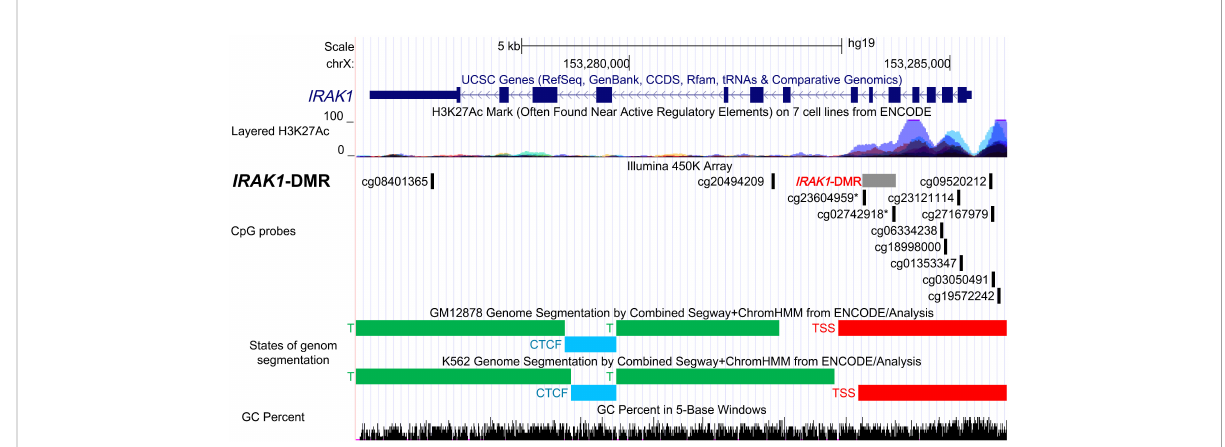
FIGURE 4 Functional characterization of the differentially methylated region in IRAK1 gene ( IRAK1 -DMR) using ENCODE Data in the UCSC Genome Browser. Genomic position of IRAK1- DMR is shown in the USCS genome browser with reference to positions of CpG-probes (Illumina 450K Methylation array), enrichment of histone 3 lysine 27 acetylation (H3K27ac) peaks (layered H3K27ac peaks generated on seven human cell lines), predicted functional genomic states assembled by ChromHMM and Segway segmentation analysis in GM12878 and K562 cell lines (red, predicted promoter region including transcription start site, TSS). The GC percent track shows the densities of G (guanine) and C